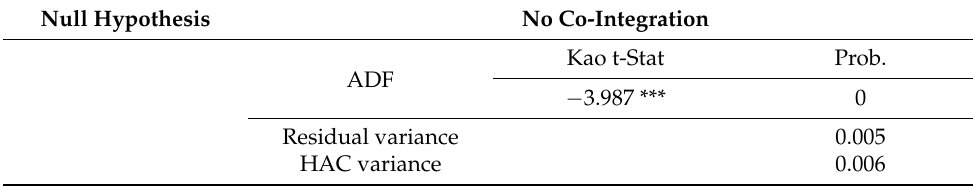
Table 6. Results of Kao